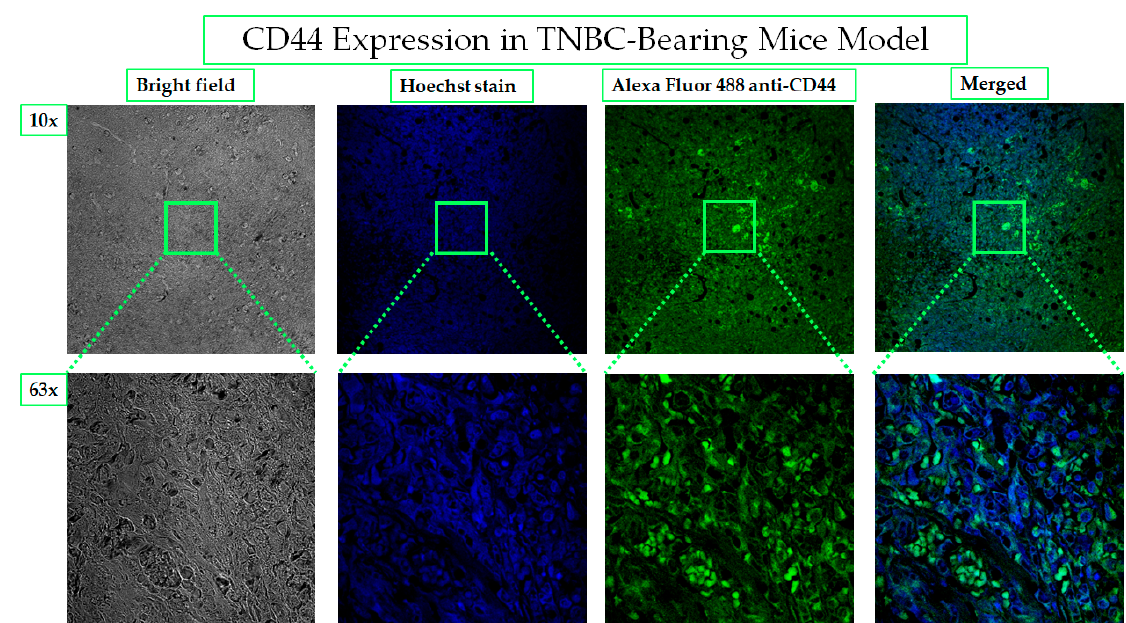
Figure 11. CD44 overexpression in TNBC- bearing mice model. The expression of CD44 in MDA-MB-231- induced TNBC in mice is considered the basis for the selection of HA as a targeting ligand for PNPs. Alexa Fluor 488 conjugated anti-CD44 antibody was used to demonstrate the homogenous distribution of CD44 receptors on the in vivo tumor. The images were taken by a confocal microscope with 10 × and 63 × magnification power.